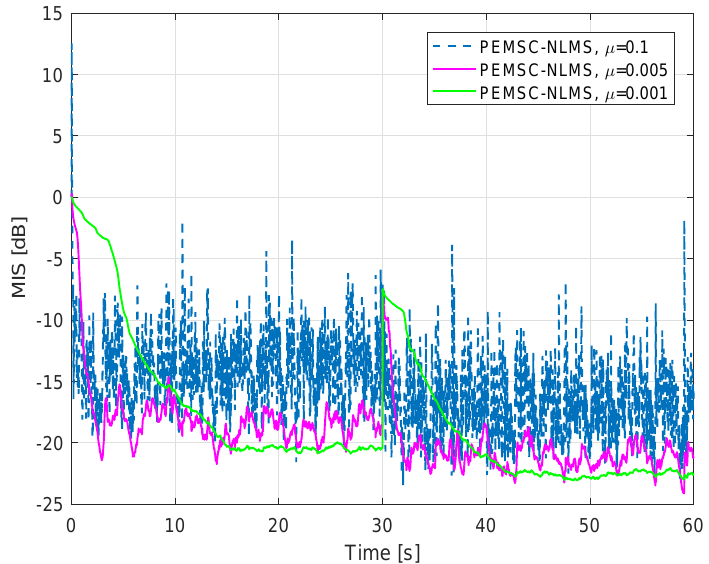
Figure 5. Normalised misalignment of the PEMSC-NLMS with µ ∈ [ 0.1,0.005,0.001 ] , speech input, feedback path changes from free-field ( F 1 ) to telephone-near ( F 2